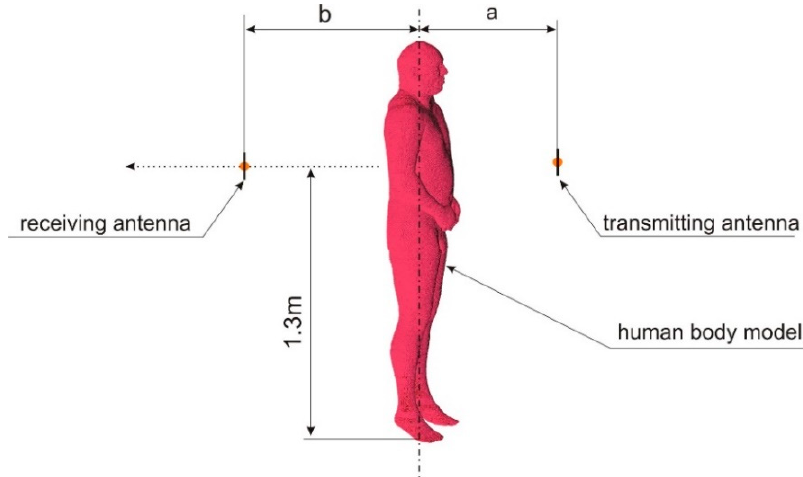
Figure 2. Geometry of the numerical experiment performed in XFdtd™ software.